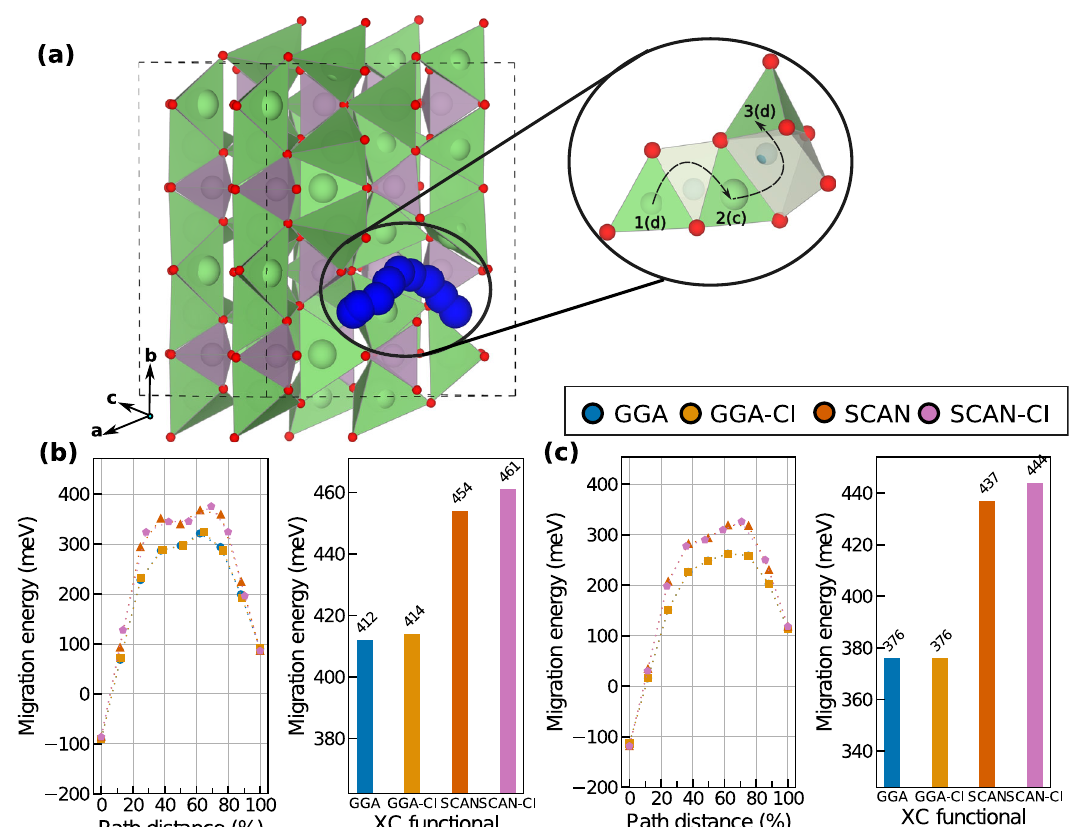
Fig. 3 Migration pathway and computed barriers for γ -Li 3 PO 4 . a 1 × 2 × 2 supercell of Li 3 PO 4 used for the NEB calculations. Green and purple polyhedra represent LiO 6 and PO 4 groups, respectively. The inset shows the migration of the Li ion along the 1(d) → 2(c) → 3(d) path (blue spheres). b MEPs and E m are plotted for the 1(d) → 2(c) pathway, without NELECT. GGA-CI and SCAN-CI indicate CI-NEB calculations with GGA and SCAN, respectively. c MEPs and E m for the 1(d) → 2(c) path, with NELECT